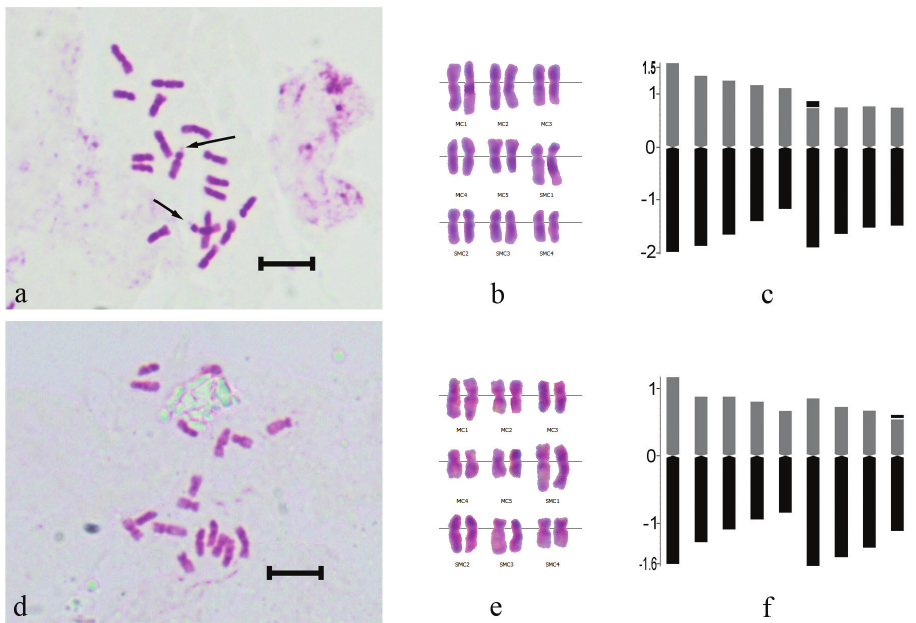
Figure 2. Somatic chromosomes, karyotype and idiogram of C. ziganensis ( a–c ); C. drabifolioides ( d–f ). Arrow indicates satellite. Scale bars = 5 µm.